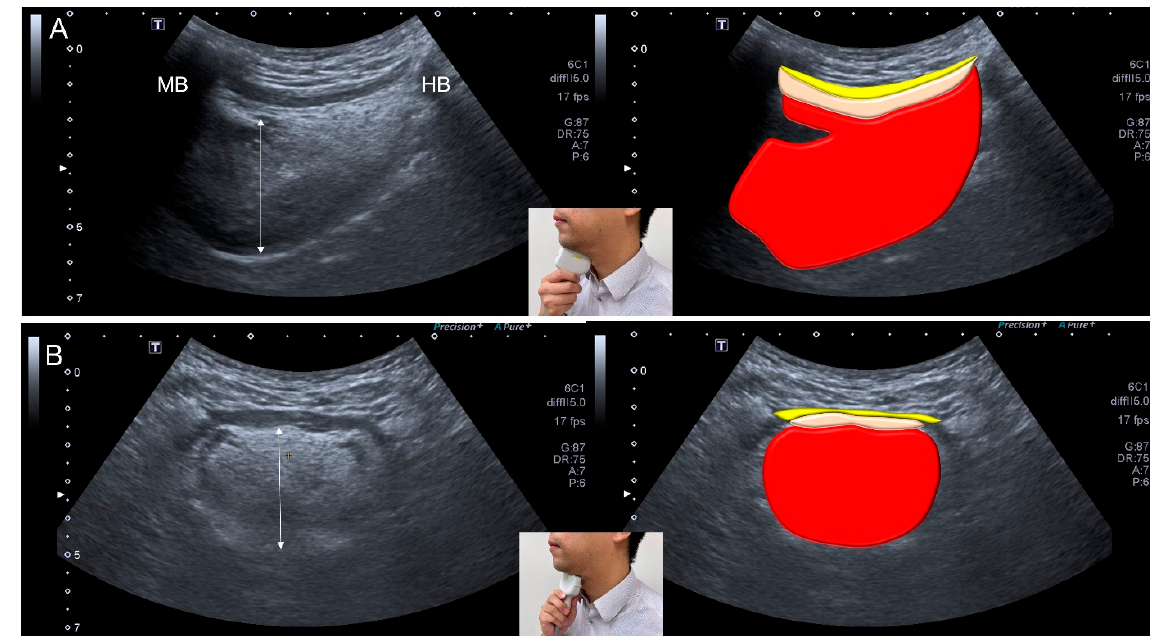
Figure 6. Ultrasonographic images and schematic drawings of tongue and adjacent muscles in the sagittal ( A ) and coronal ( B ) planes. Tongue muscle: red color block; geniohyoid muscle, pink color block; mylohyoid muscle, yellow color block; MB: mandible; HB: hyoid bone; double arrowed line, thickness of the tongue muscle.